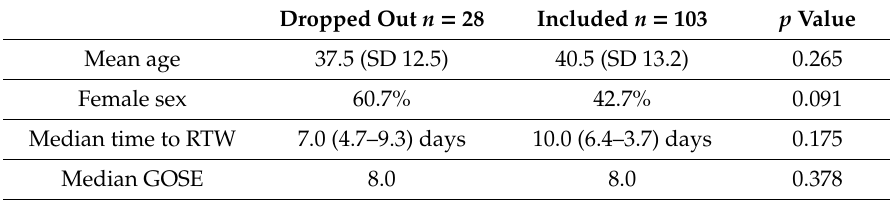
Table 1. Comparison between patients dropped out from and included in the